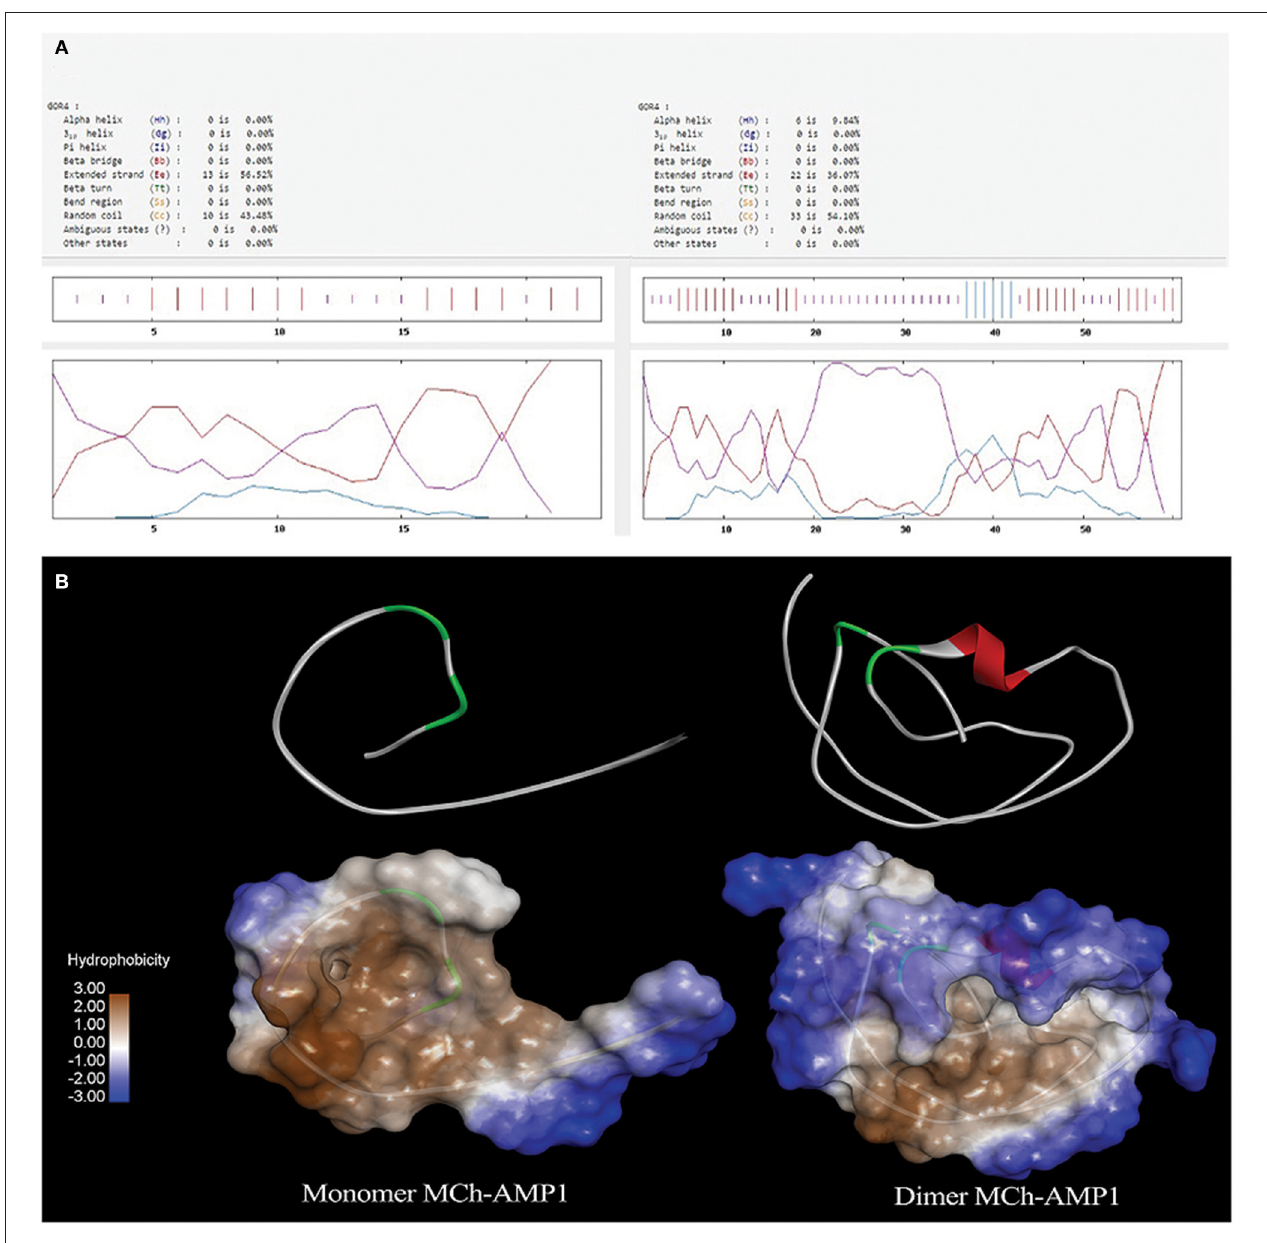
FIGURE 1 | (A) Result of secondary structure prediction for MCh-AMP1 and DiMCh-AMP1 peptides by GOR4 software. (B) I-TASSER server was used to predict the 3D structure of the MCh-AMP1 and DiMCh-AMP1 peptides. Results were read by Accelrys Discovery Studio Visualizer 2.0